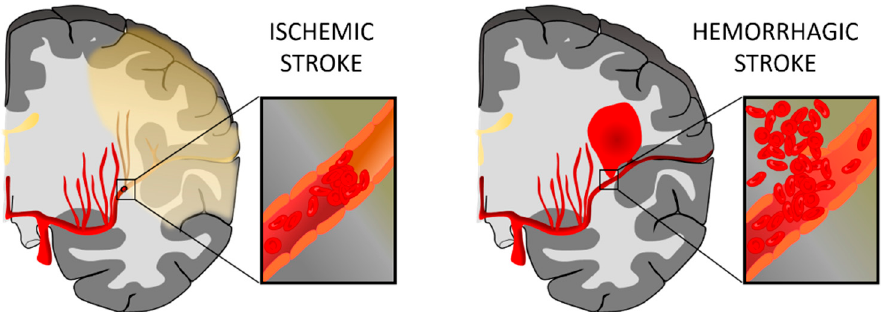
Figure 1. Representation of ischemic stroke and hemorrhagic stroke. In an ischemic stroke, the clot blocks blood flow to an area of the brain; meanwhile, hemorrhagic stroke happens when a blood vessel breaks and bleeds into the brain. Figure created with BioRender.com.